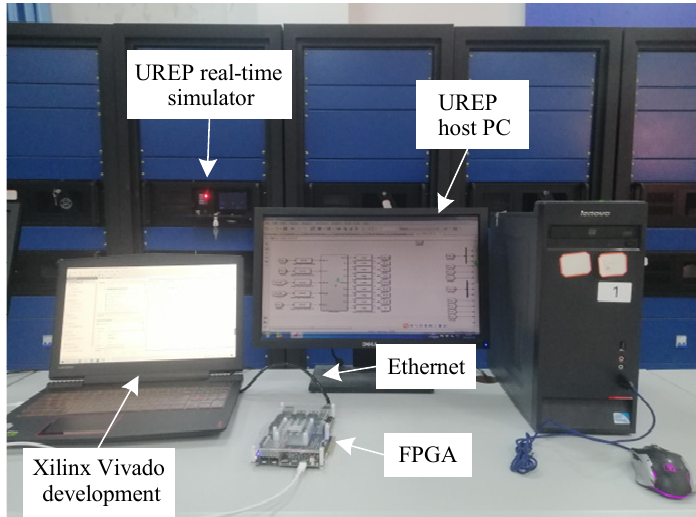
Figure 13. FPGA–UREP physical simulation platform.